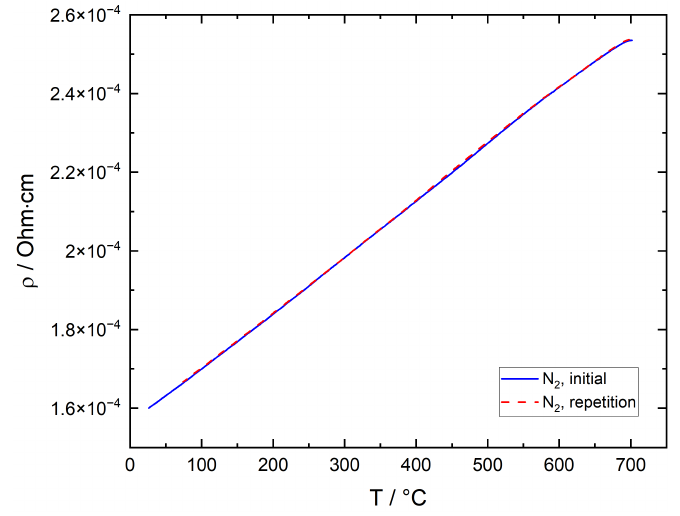
Figure 9. Electrical resistivity of ITO thin film as a function of temperature measured in N 2